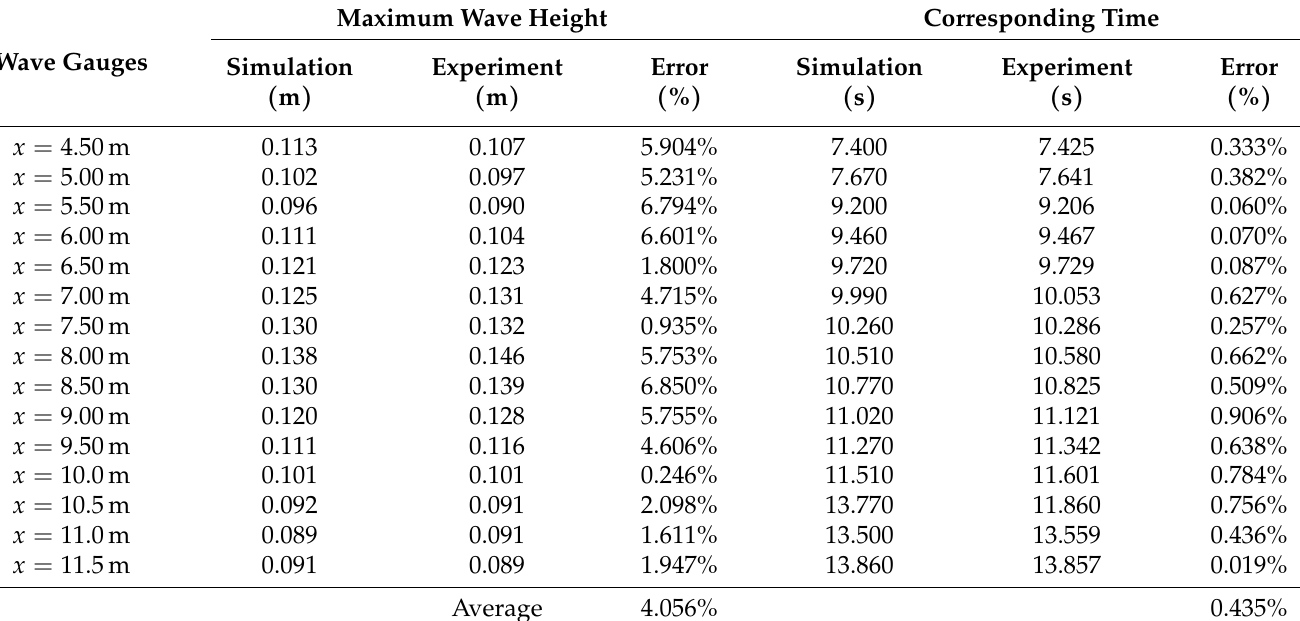
Table 2. Comparison of the maximum wave height and respective corresponding time between numerical and experimental